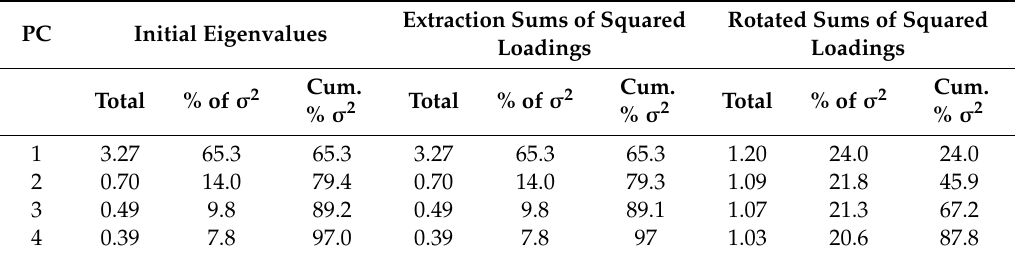
Table 5. PCA of Driving Behavior: Unrotated and Rotated PC Loadings, Eigen Values, and Percentage of Variance ( σ 2 ) Captured.